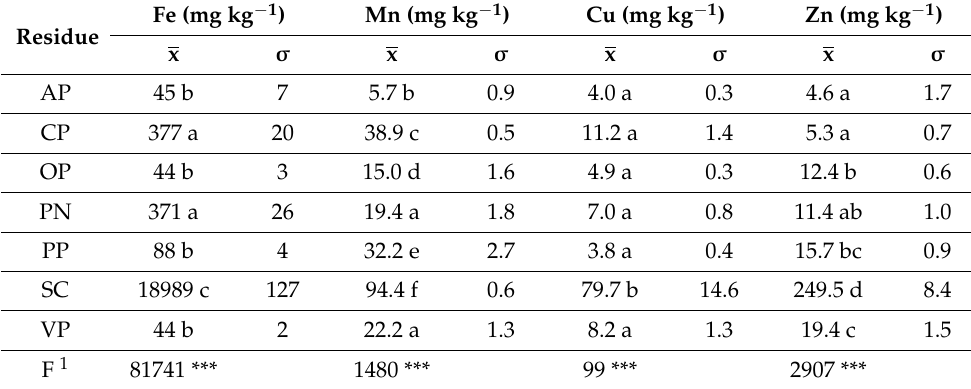
Table 4. Elemental micronutrient composition, average content (x) and standard deviation ( σ ) for each